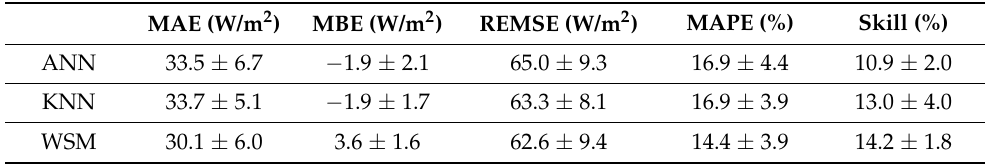
Table 5. Forecasting results comparison among different methods over all horizons.